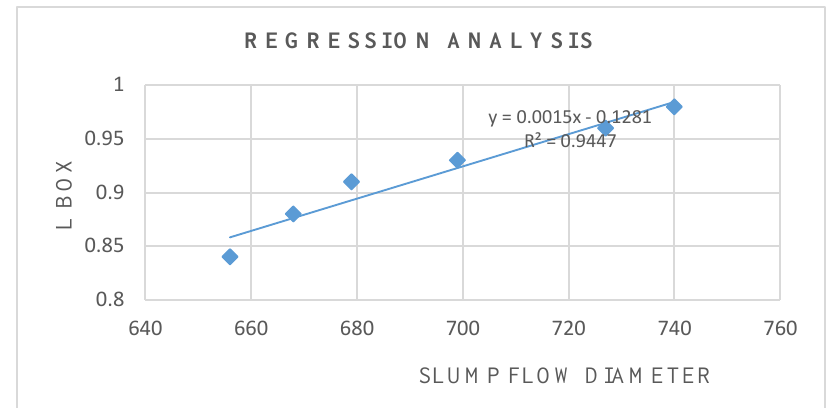
Fig. 15. Regression Analysis Slump Flow vs L Box.